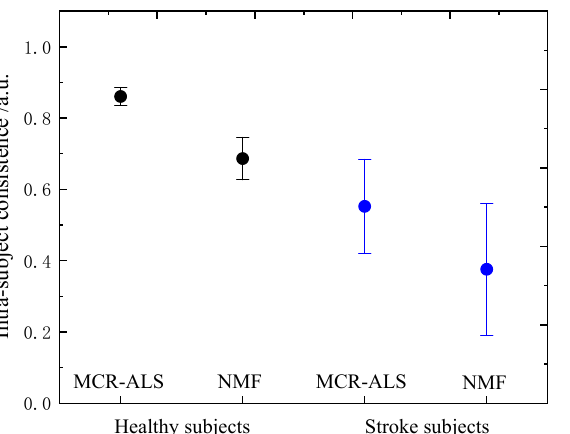
Figure 8. The statistical results of intra-subject consistency computed to compare the standard approach (NMF) and the novel approach (MCR-ALS) for all healthy and stroke subjects.